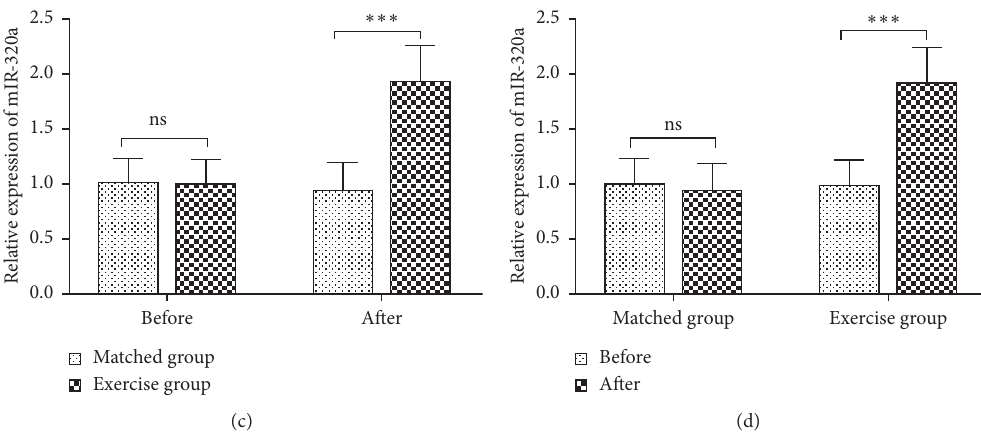
Figure 1: Relative expression of MALAT1 and miR-320a in obese children and adolescents before and after intervention. (a) There was no difference in MALAT1 expression between the matched group and the exercise group, but 12-week exercise training in the exercise group significantly reduced the expression of MALAT1 compared to the matched group receiving only dietary control. (b) After exercise training, the expression of MALAT1 was decreased in obese children and adolescents. (c) There was no difference in miR-320a expression between the matched group and the exercise group, but 12-week exercise training in the exercise group significantly increased the expression of miR- 320a compared to the matched group receiving only dietary control. (d) After the exercise training, the expression of miR-320a was elevated in obese children and adolescents. ns, no significance; ∗∗∗ P < 0 . 001. Table 3: Correlation of the MALAT1/miR-320a axis with the baseline features of obese children and adolescents after exercise.